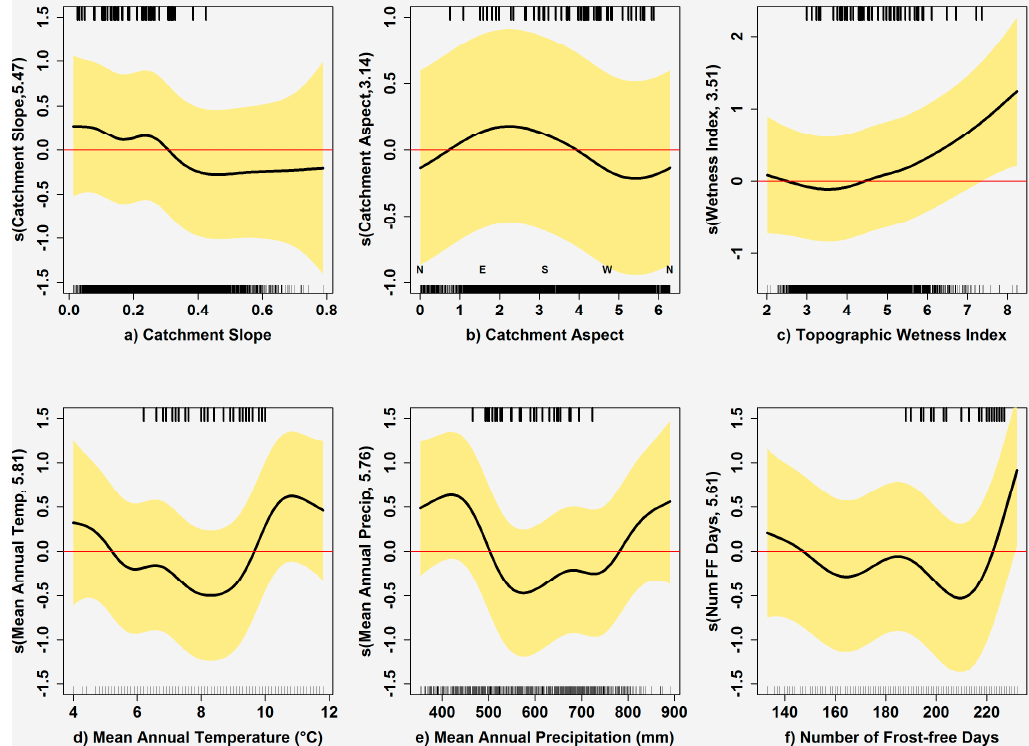
Figure 3. Generalized Additive Model (GAM) smooth plots for the models with three terrain and one climate predictor represent the change in the Refugial Gradient (RG) value ( y -axis) relative to variation in terrain and spatial climate ( x -axis). Relationships with terrain variables ( a – c ) remained the same for all models that included one climate variable. Neighborhoods that were more densely populated with refugia occurred on gentle slopes, but sparsely populated neighborhoods were more likely on moderate and steep slopes ( a ). Refugia were more abundant in neighborhoods on east-southeasterly aspects ( b ) and areas with higher soil moisture ( c ). Greater density of refugia tended to occur at the high and low end of the range in variability in climate ( d – f ). Confidence intervals, shaded yellow, include the uncertainty about the overall mean (R-mgcv gam plot option seWithMean = TRUE [55]). Rugs at the bottom of each plot represent the distribution of random samples; the top rugs represent the distribution of field samples.